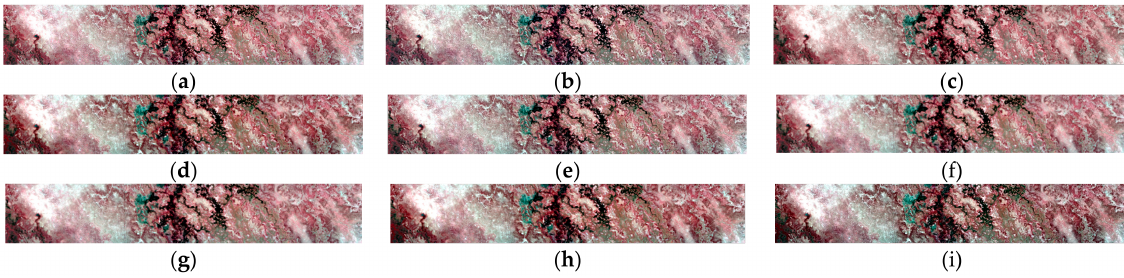
Figure 14. RGB images of ground truth, the different methods and the proposed EDRN method for the Pavia Center dataset: (a) Ground truth, ( b ) AWLP, ( c ) CNMF, ( d ) GIHS, ( e ) MTF_GLP, ( f ) HPF, ( g ) SFIM, ( h ) DIP-HyperKite and ( i ) EDRN.